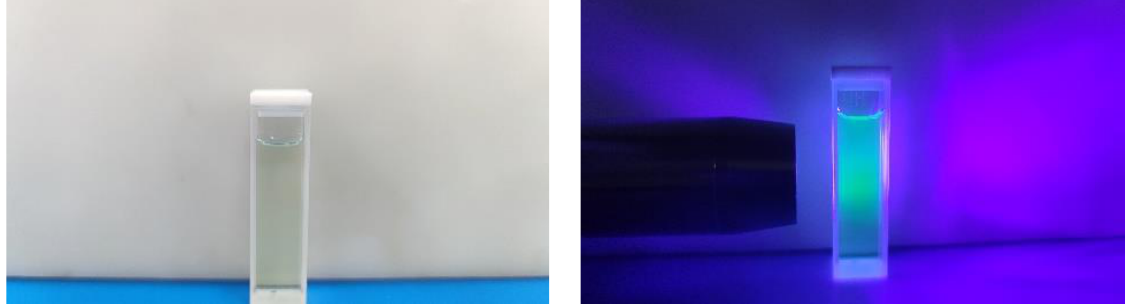
Figure 5. Color development of CQD-W under natural light ( left ) and UV light ( right ) irradiation.